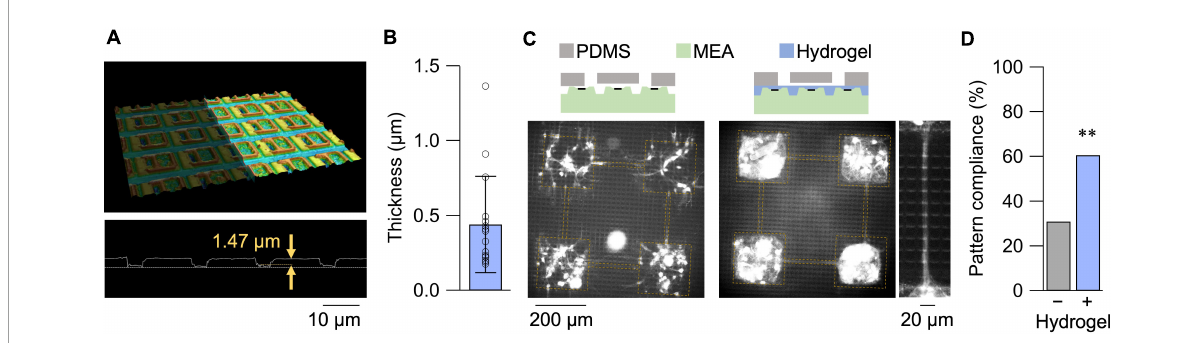
FIGURE1 Hydrogel coating of HD-MEA. (A) 3D confocal micrograph of the HD-MEA chip (top) and its surface profile (bottom). (B) Thickness of the hydrogel films in their dried state measured by confocal microscopy. Data shown as mean ± SD, with plots for individual data points. (C) Primary neurons cultured on HD-MEA chip without (left) and with (right) the hydrogel coating. A magnified view of the microchannel region of a separate sample is also presented for the hydrogel-coated chip. The cells were stained with Neu-O (Er et al., 2015), and yellow dashed lines depict presumptive locations of microfluidic structures. (D) Fraction of compliant patterns with and without the hydrogel coating. ∗∗ p < 0.01 (chi square test).